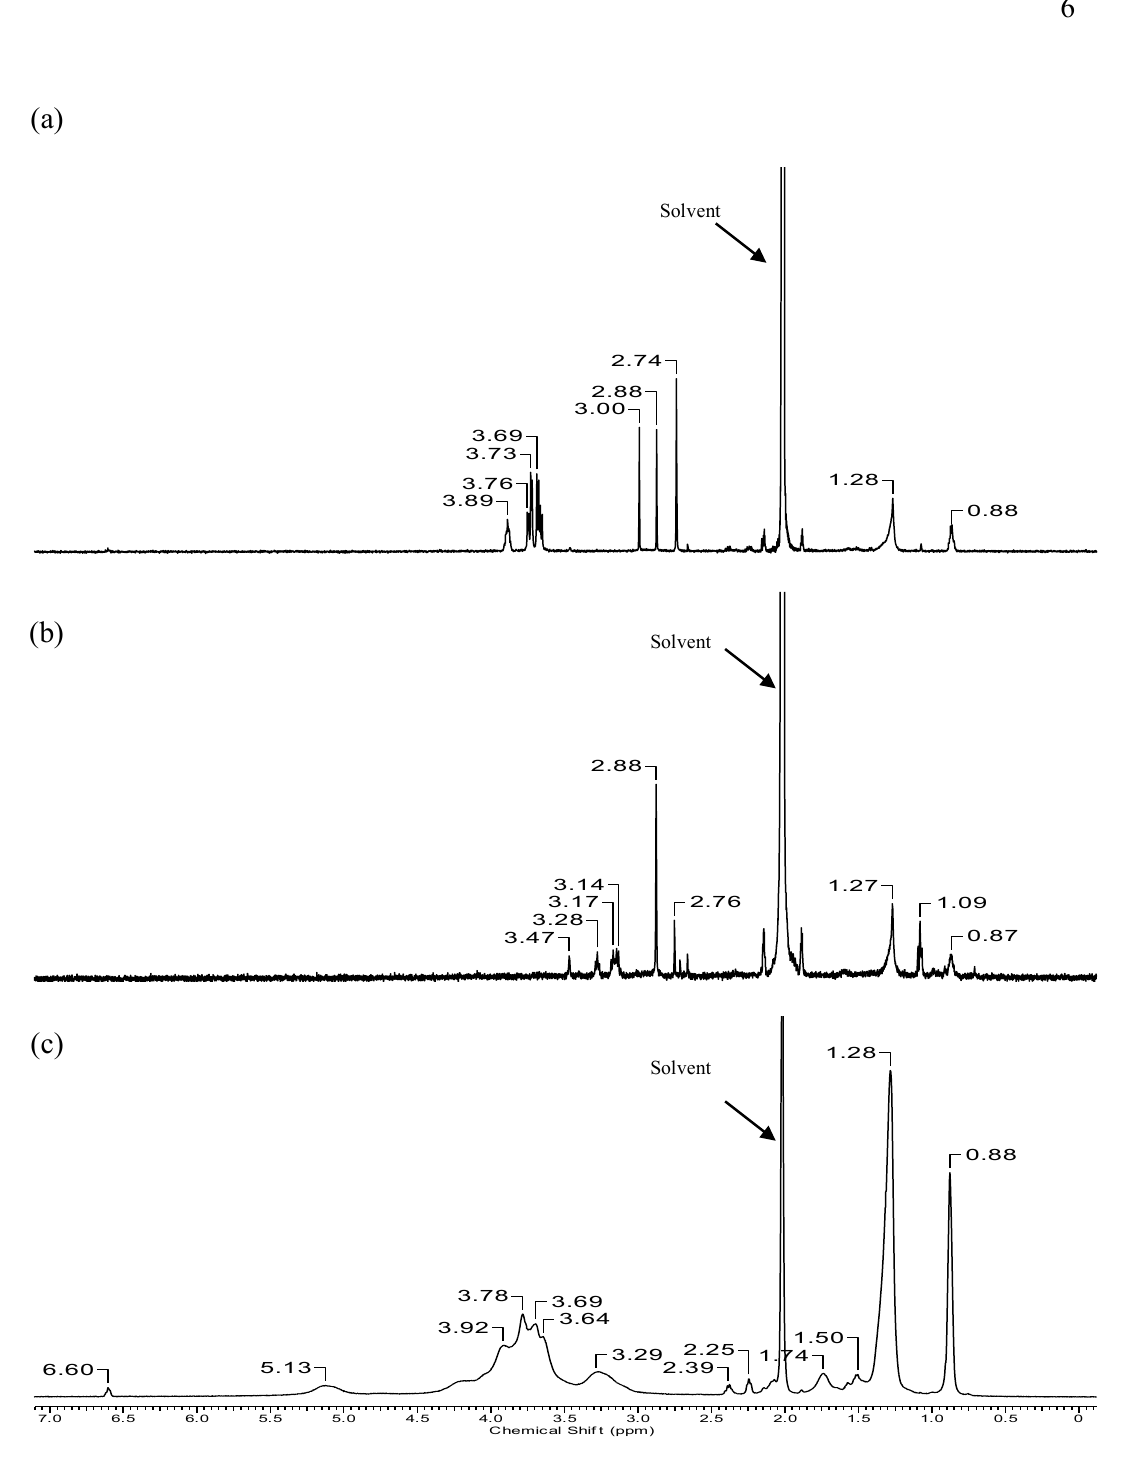
Figure 4: 1 H NMR spectra of (a) NOOSC, (b) NONSC and (c) NOOGC in acetic acid-d (99.5%).